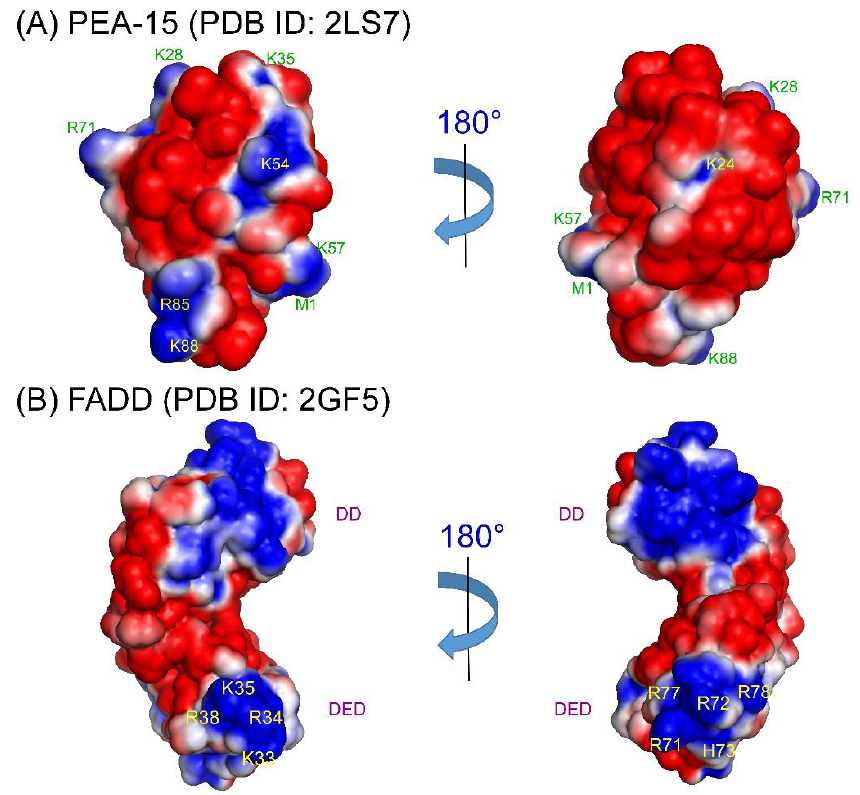
Figure 2. Surface electrostatics of ( a ) PEA-15 (PDB ID: 2LS7) DED and ( b ) FADD (PDB ID: 2GF5) DED. ( a ) PEA-15 DED possesses two distinctive surfaces with one surface consisting of positive/negative patches, and the other surface consisting a more continuous negative patch with a positively charged pocket around K 24 , which could provide the self-association site for p-Ser 104 /p-Ser 116 . ( b ) FADD DED possesses two positive patches on opposite surfaces, which could provide binding interface to PEA-15 negative patch on DED and/or C-terminal phosphoryl groups. Surface electrostatics was calculated using APBS 1.4.1 [94] and plotted using PyMOL 1.7.2 [95]. Positive charges are shown in blue with residues labeled, and negative charges are in